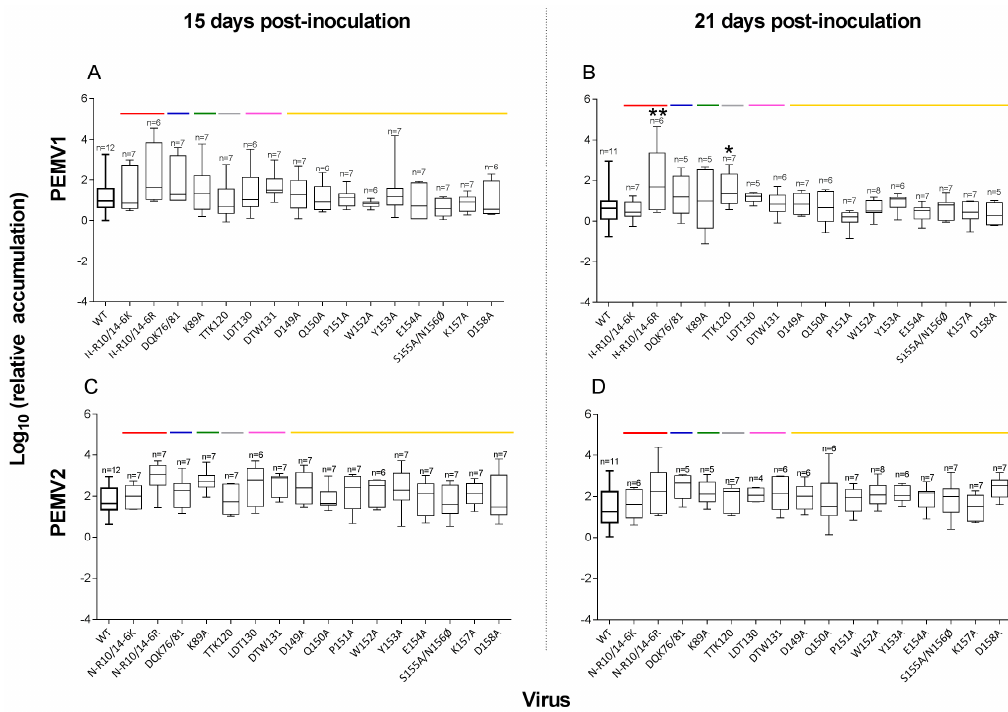
Figure 2. Accumulation of WT and mutant PEMV within inoculated leaves. ( A , B ) PEMV1; ( C , D ) PEMV2, WT and mutant accumulation at 15 and 21 days post-inoculation (dpi) of pea leaves, respectively. Virus accumulation was determined by RT-qPCR with reference to actin. All the mutants are able to replicate in the inoculated leaves as the same level as WT. The horizontal line within each box indicates the median value (50% quantile), while the box delimits the 25% and 75% quantiles. Colored lines correspond to the location of each mutant in specific coat protein domains as depicted in Figure 1. The number ( n ) of infected leaves tested for each virus are indicated with significant differences relative to WT shown (* p < 0.05; ** p < 0.01).